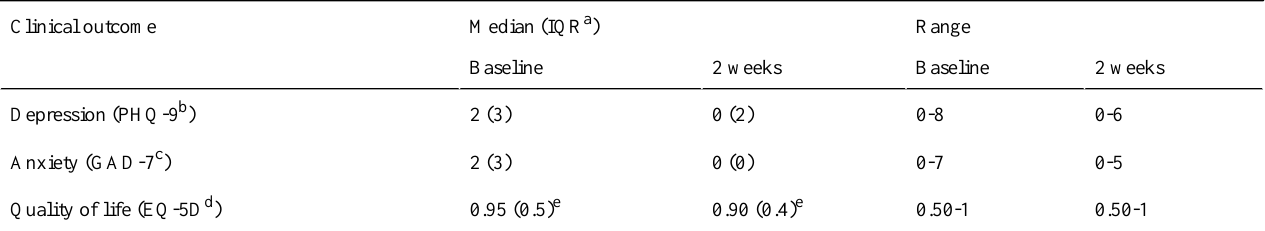
Table 4. Participant ratings of depression, anxiety, and quality of life from the cross-sectional study (n=10).